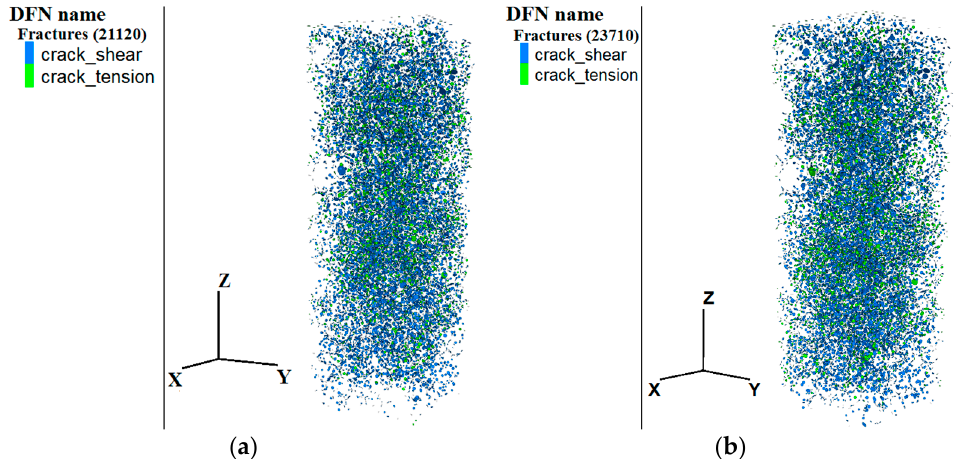
Figure 14. Number of concrete cracks at the second stage point with ( a ) 75 and ( b ) 150 freeze–thaw cycles.